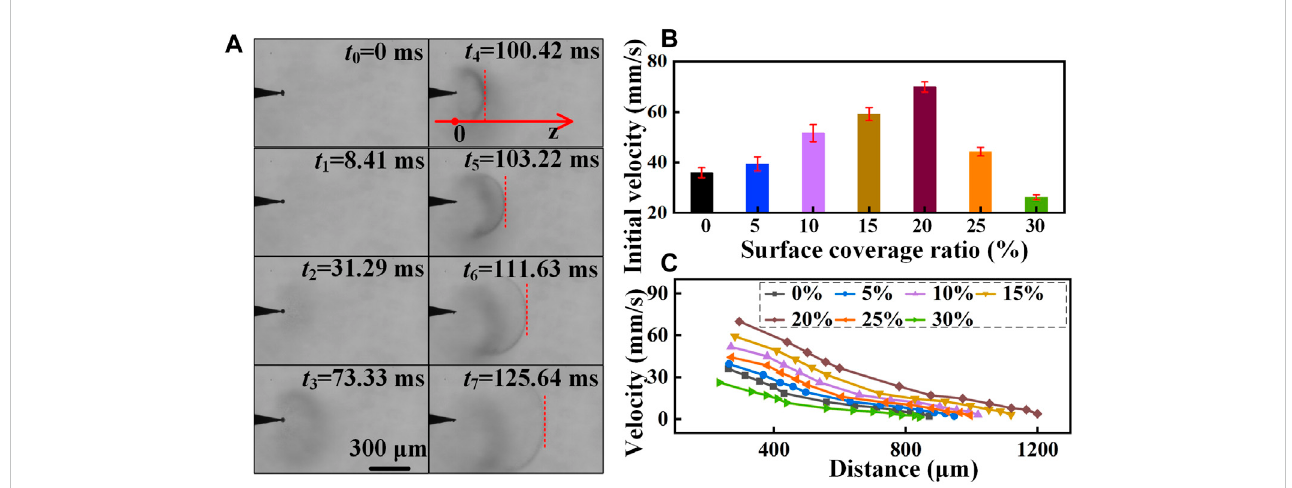
FIGURE 4 The process of micro-explosion. (A) Pictures of micro-explosion acquired at different moments. The dashed red lines indicate the fl ow fronts of shockwave-like fl ow. (B) The relationship betweentheinitial fl owvelocityand surfacecoverage ratio. Error bars represent standard error. (C) The relationship between the fl ow velocity and the distance. The distance is calculated from the fi ber probe tip to the fl ow front along the optical axis.